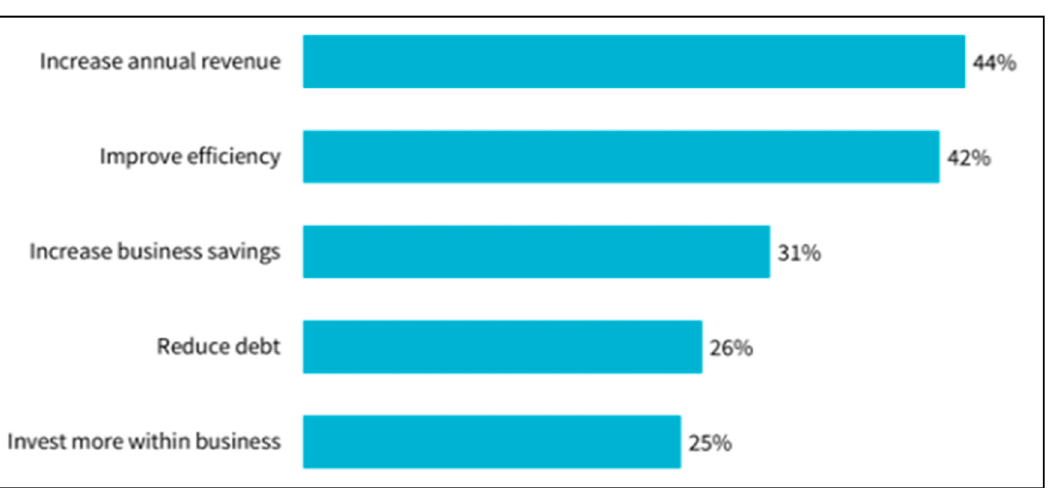
Figure 1. Thailand SMEs Performance. Source: RFI Group—Thailand SME Banking Council (2017).